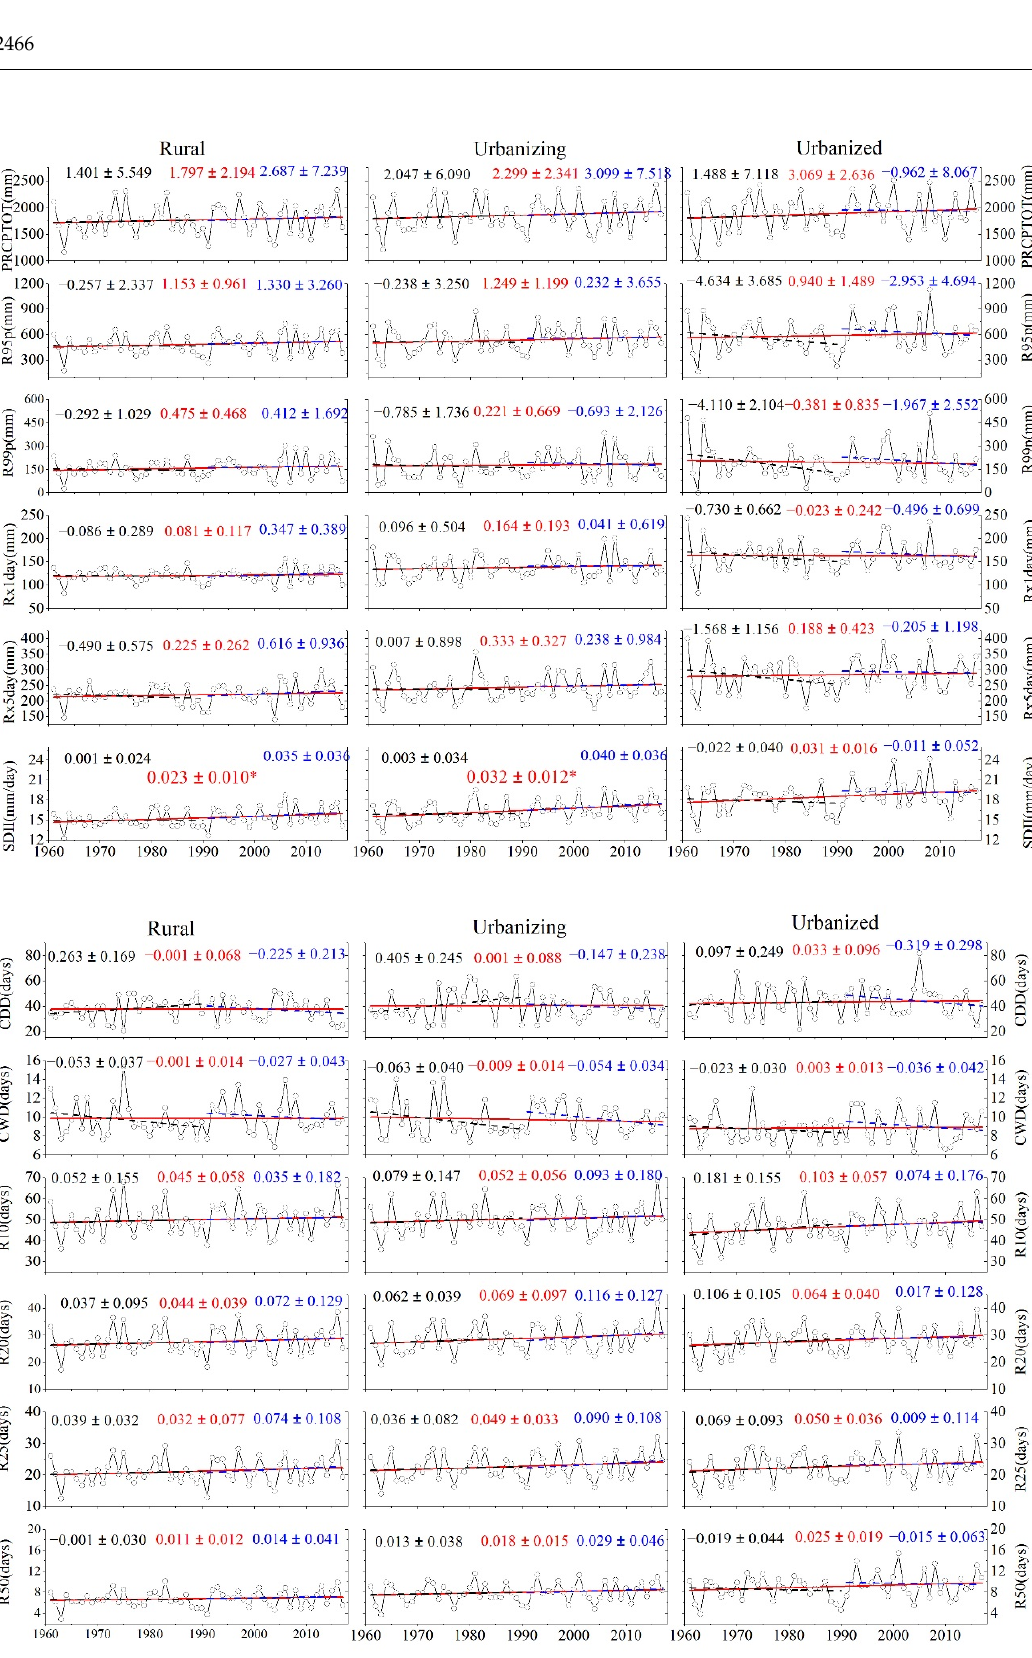
Figure 2. Trends of annual averaged extreme precipitation indices for rural, urbanizing, and urbanized areas over the PRD during 1961–2017. Red solid lines mean linear trends for all the indices during 1961–2017, and black and blue dashed lines are linear trends during 1961–1990 and 1991–2017, respectively, with the number being the slope of trends. The asterisk symbol means a significant increase or decrease at the 0.05 level.